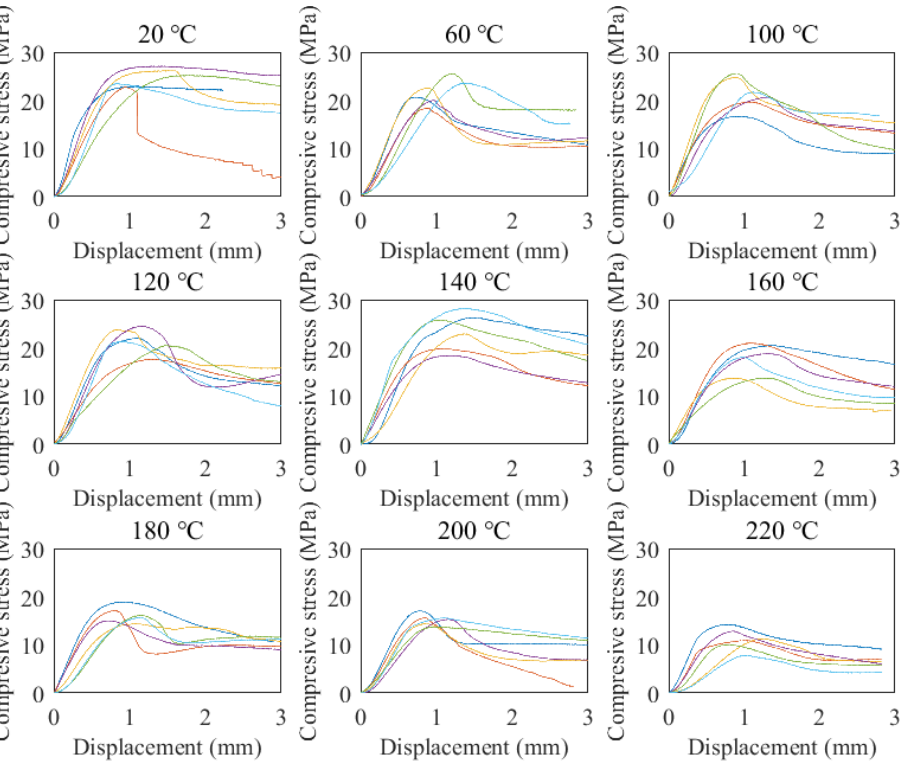
Figure 8. Stress-displacement responses of all the specimens in compression.